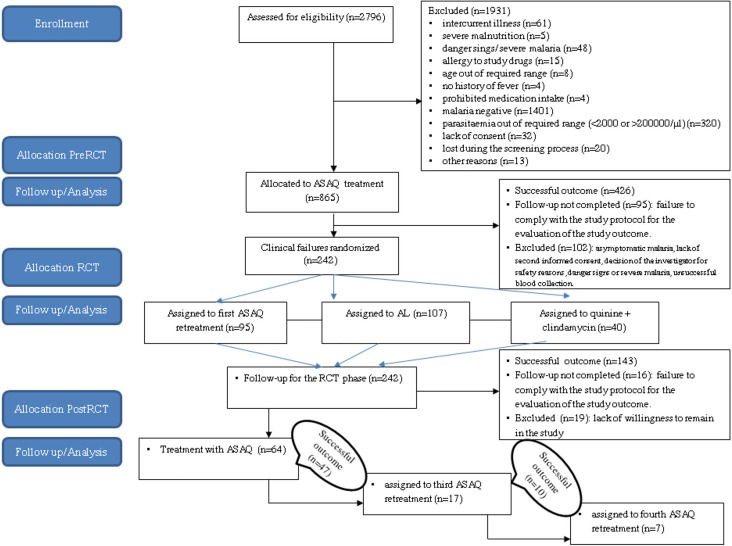
Trial flow chart, patients’ randomization and treatment assignment in Lisungi, Kinshasa, DR Congo.